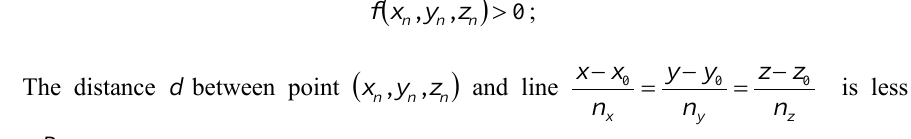
Fig. 8. CTA volume data segmentation after denoising.